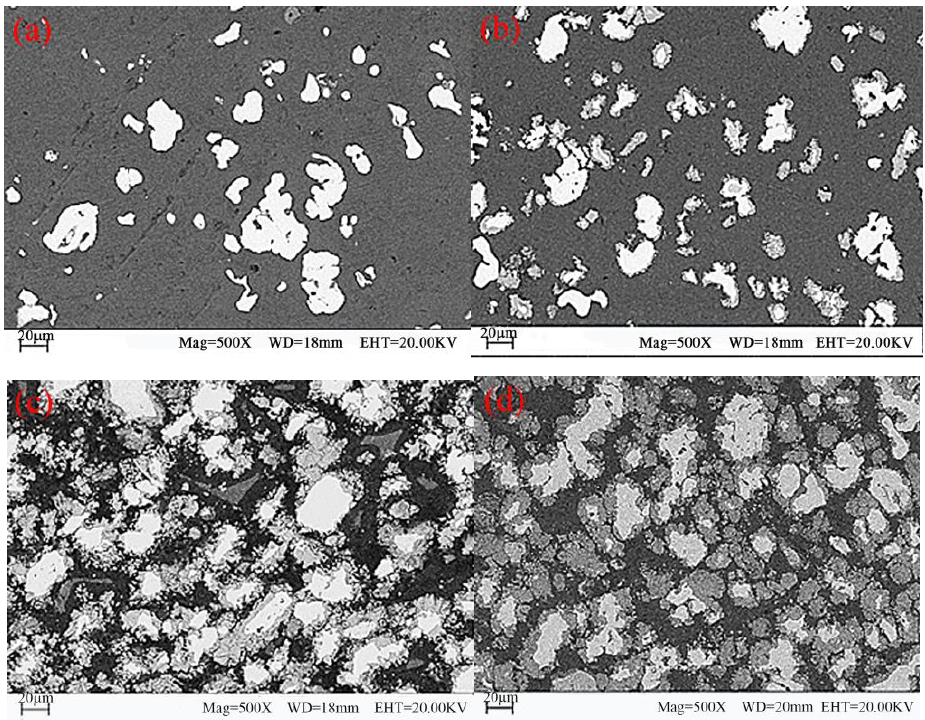
Figure 4. SEM images of the Fe/Al composites. ( a ) 500 °C, ( b ) 520 °C, ( c ) 550°C, and ( d ) 600 °C.